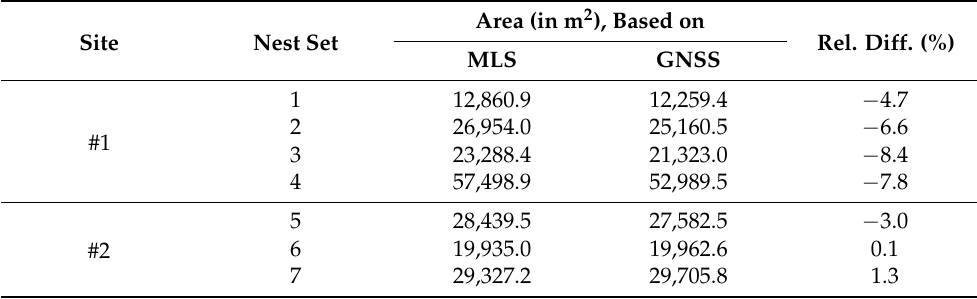
Table 3. The area of the convex hulls determined by the nests within the 14 datasets and the relative differences between the two instruments (GNSS vs.